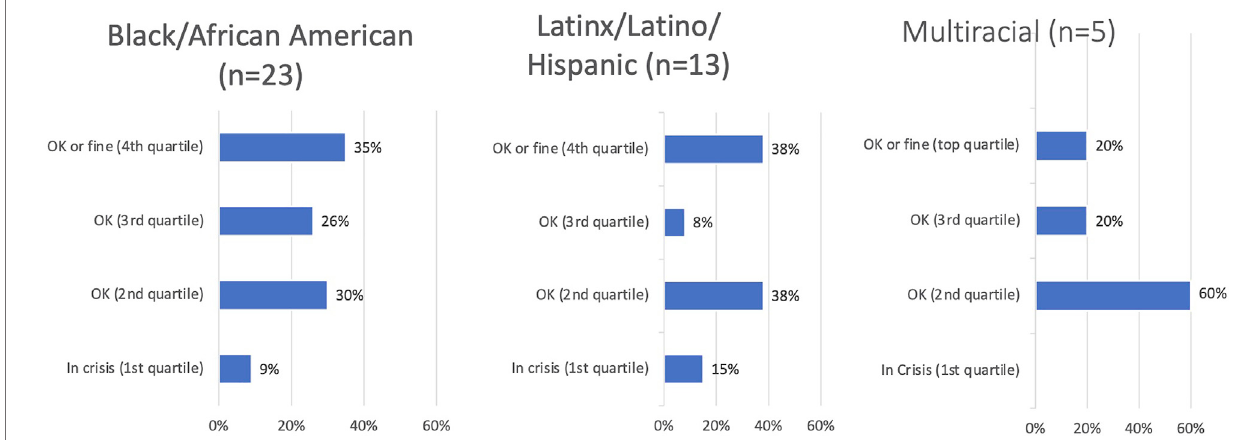
FIGURE 4 | How are students feeling? (By race/ethnicity).